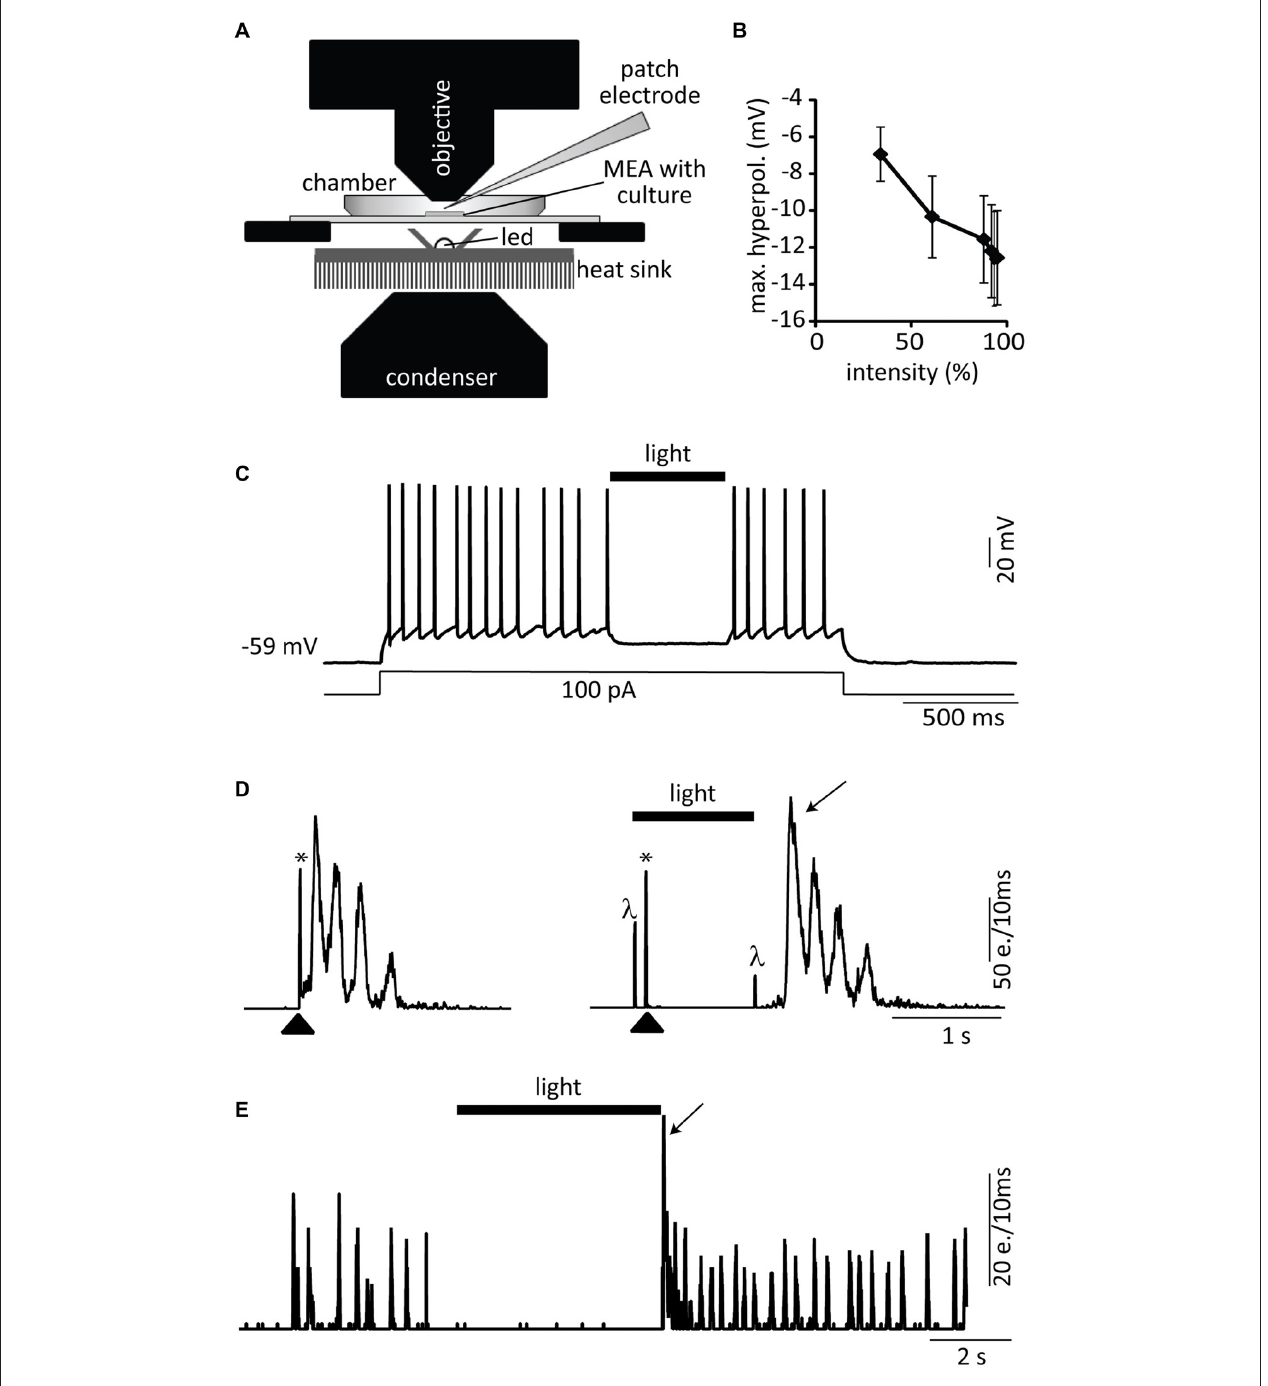
FIGURE 5 | Optogenetic silencing with eNpHR. (A) Setup configuration: a 591 nm stimulation LED was placed just below the MEA located on an upright microscope. Dissociated cells originating from FBs of Nes-eNpHR mice ( B–D , E14 and E, P1) were directly cultured on MEAs in absence of host tissue. (B) Yellow light pulses (1–2 s) of increasing intensities (expressed in % of maximum) lead to progressively increased hyperpolarizations ( n = 5). (C) Representative current-clamp trace showing the strong yellow light mediated inhibition of a current-step induced train of action potentials. (D) Electrical stimulation through an electrode of the MEA (arrowhead, left graph, network activity plot). One second long yellow light pulses starting 100 ms before the MEA stimulation suppressed bursts (right graph). (E) Example of spontaneous network activity inhibited by sustained yellow light illumination. Both, electrical stimulation ( ∗ ) and onset as well as offset of the light pulses ( λ ) induce electrical artifacts. Activity rebound after light pulse (arrows in D,E ). e. = events. Black bars (light). The LED intensity was set at 94% of its maximal light output in (C–E) .